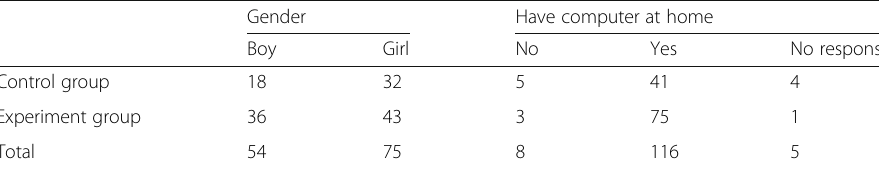
Table 2 Descriptive statistics of students ’ demography